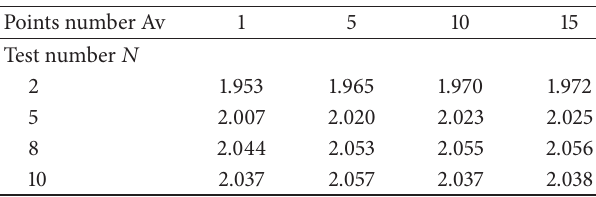
Table 3: Identified damping ratio result under different test number and average points